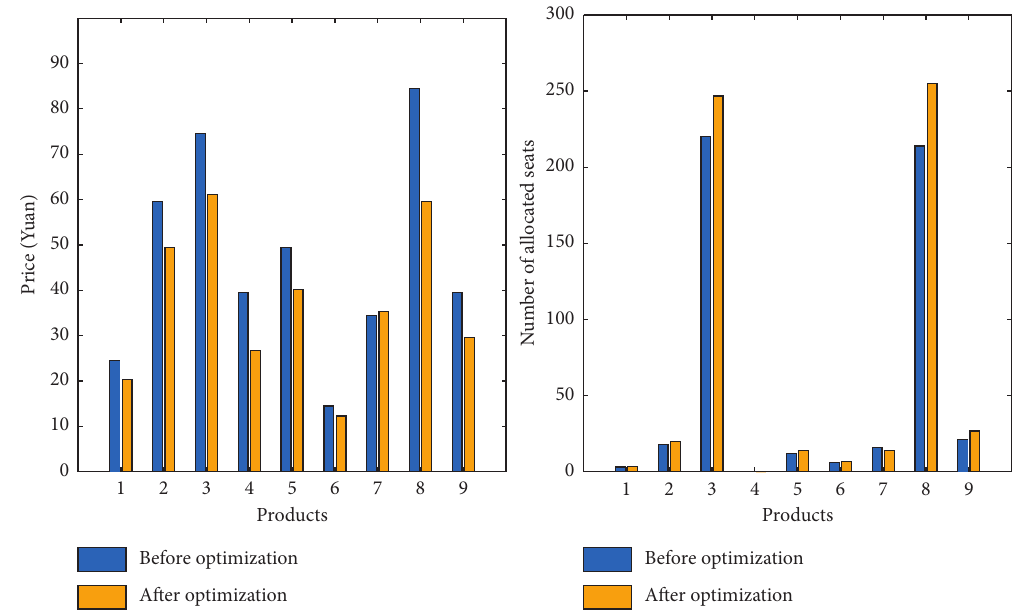
Figure 5: Price and number of seats during the booking horizon before and after optimization.